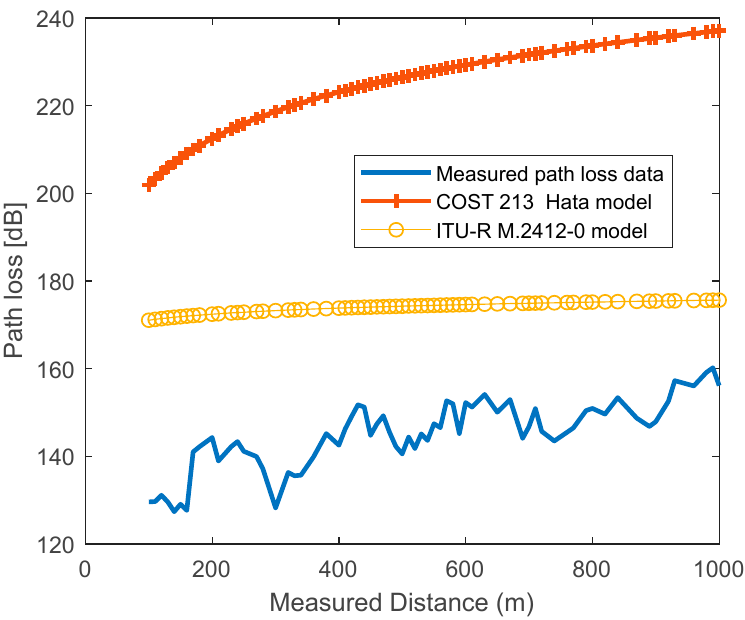
Figure 4. Measured Path loss values versus distance and Prediction comparison with standard COST 231 and ITU-R M.2412-0 model in site 1 Location 2.